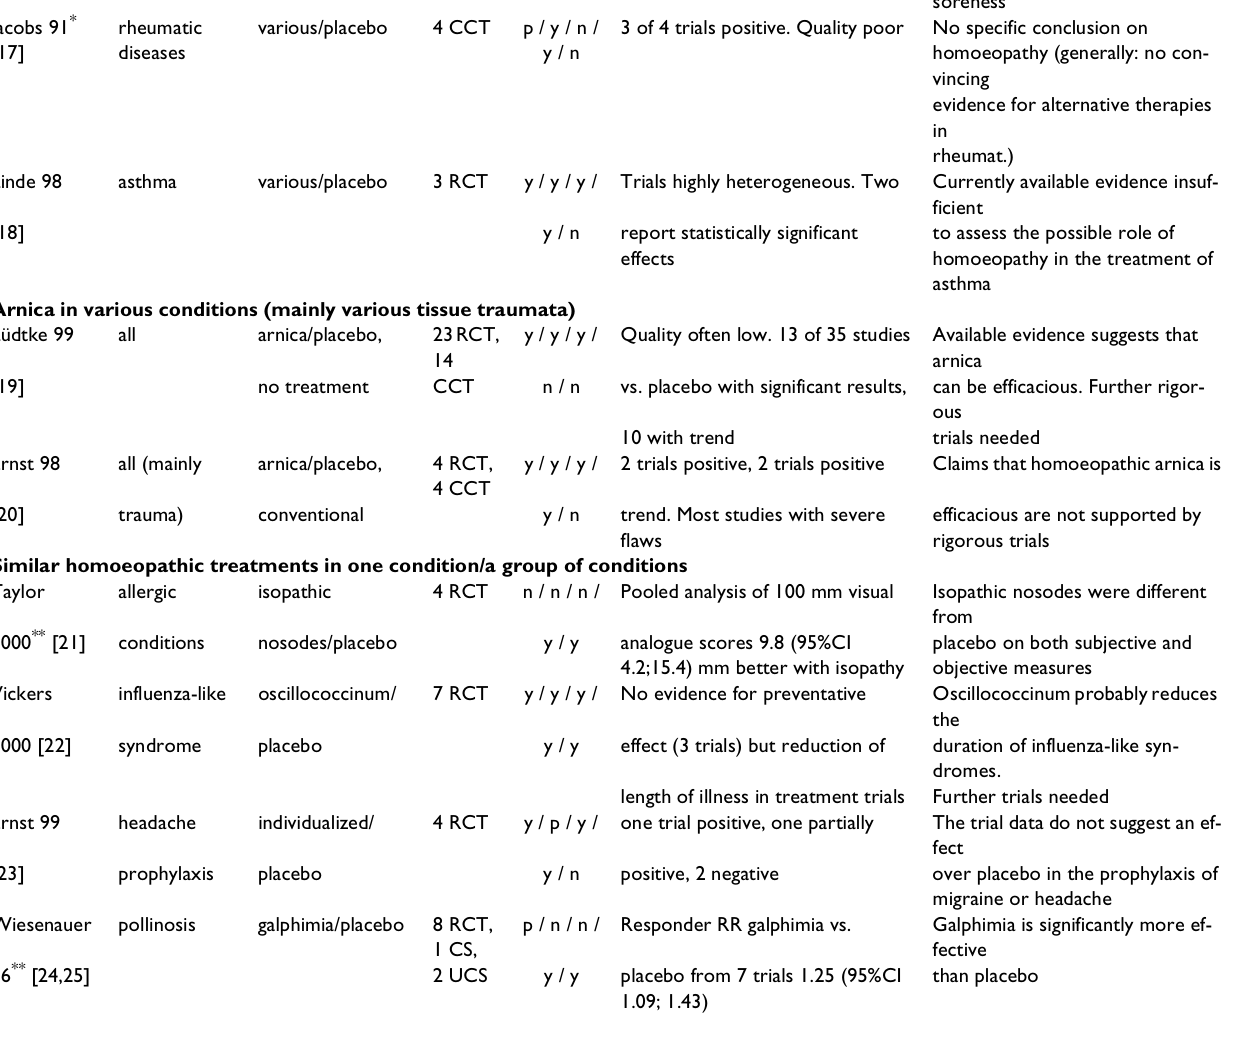
Table 1: Systematic reviews of clinical trials of homoeopathy